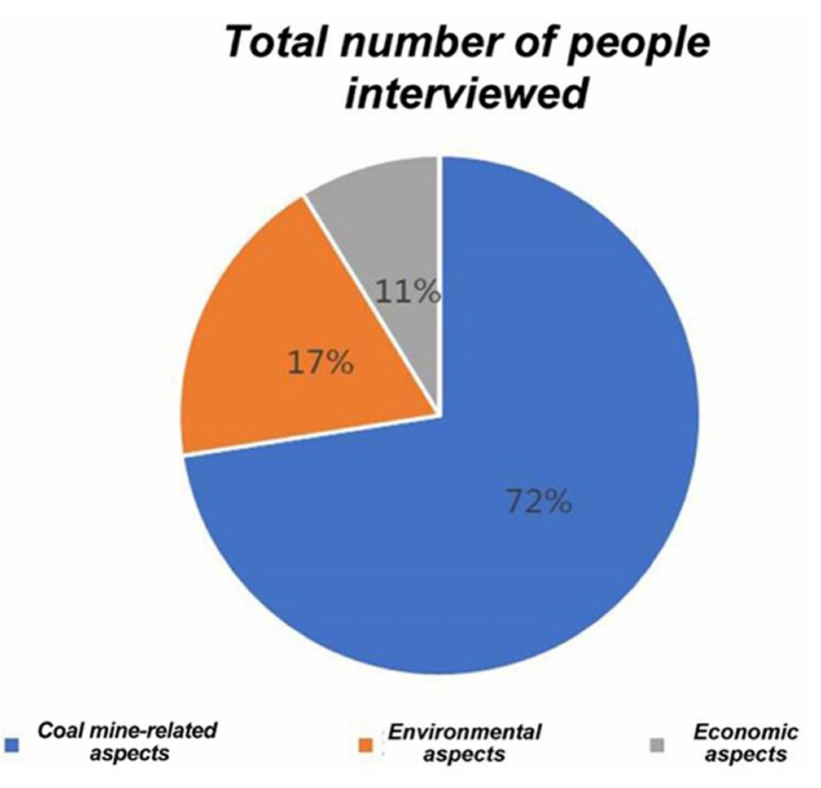
Figure 5. Public impressions of Pingdingshan.